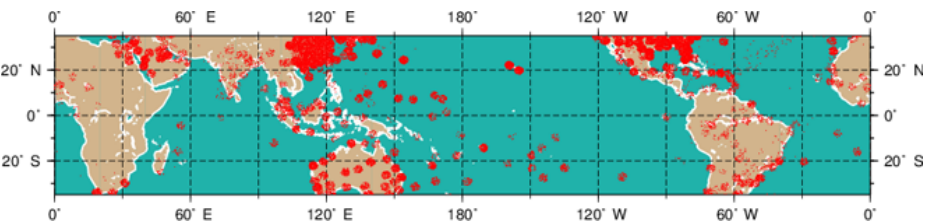
Figure 9. Location of COSMIC soundings (red dots) collocated with the operational radiosonde soundings in latitudes between 35 ◦ S and 35 ◦ N for the period from 17 February 2007 to 7 November 2010.